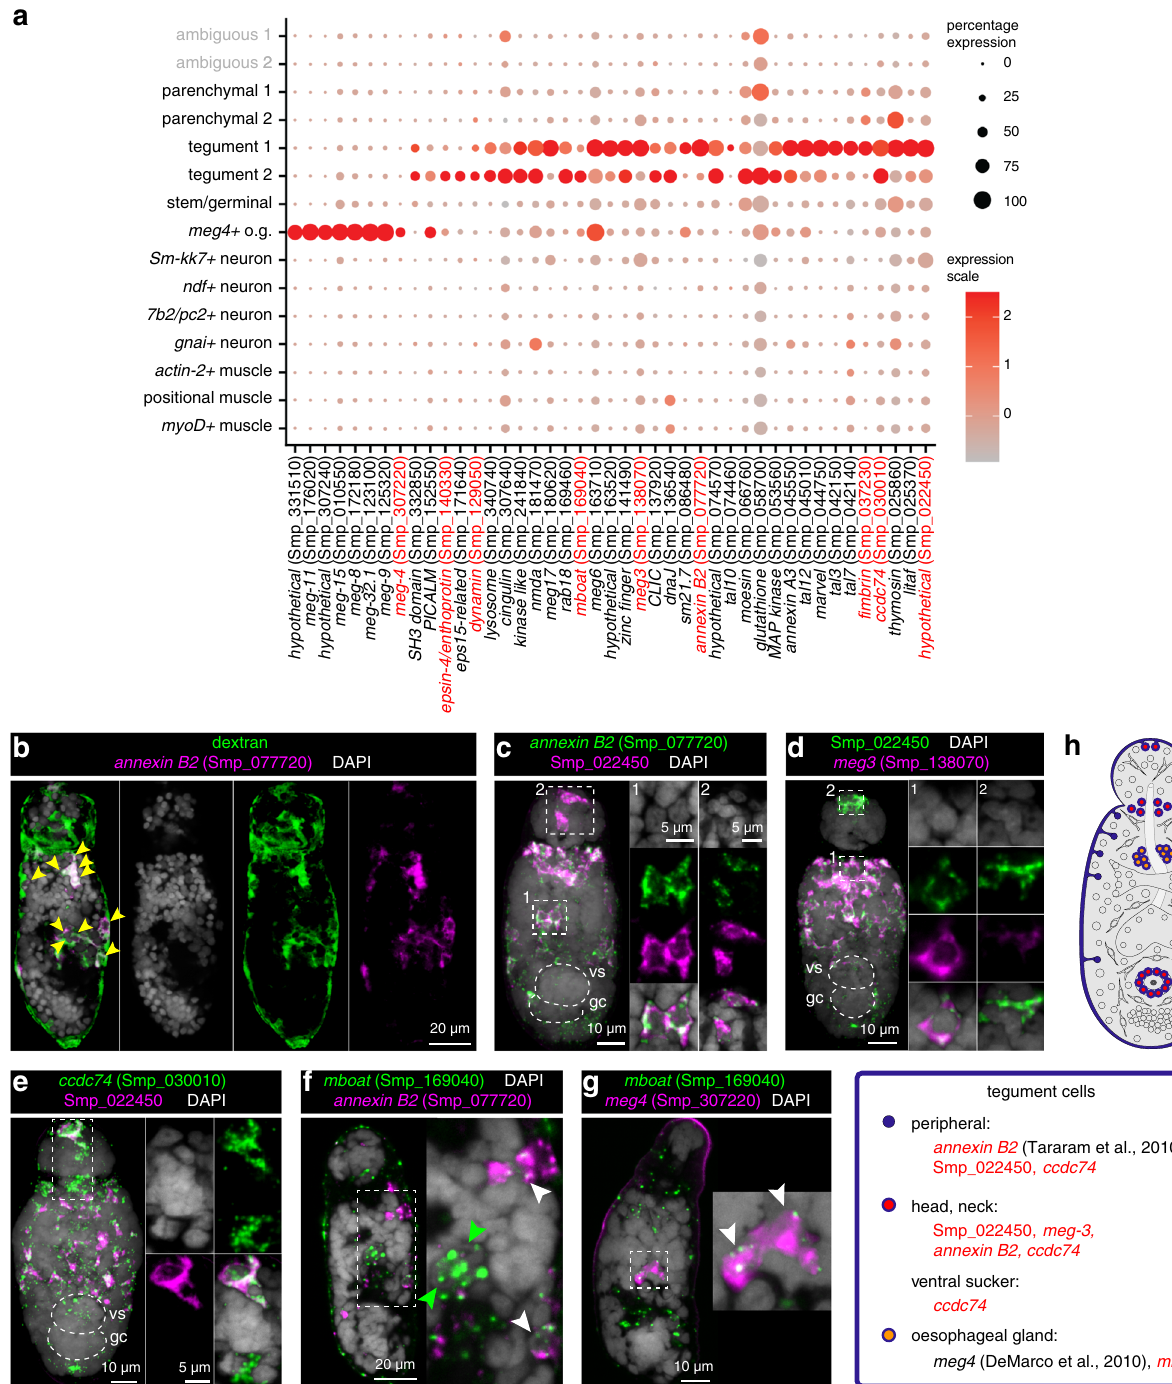
Fig. 3 Two distinct populations of tegumental cells in schistosomula. a Expression pro fi les of cell marker genes that are speci fi c to or enriched in the tegument clusters. Genes validated by ISH are marked in red. b annexin B2 + cells have taken up the fl uorescent dextran. Yellow arrowheads indicate double-positive cells. Single confocal sections are shown. c Double FISH of Tegument 1 markers annexin B2 (Smp_077720) and Smp_022450. The majority of the cells show co-localisation (white signal). Left: MIP; right: zoomed in confocal sections. vs: ventral sucker; gc: germinal cell cluster. d Double FISH of Tegument 1 markers Smp_022450 and meg3 (Smp_138070). The majority of the cells show co-localisation (white signal). e Double FISH of Tegument 1 marker (Smp_022450) with ccdc74 (Smp_030010), MIP. The majority of cells show co-localisation (white signal), while a subset of cells in the neck region of the worm show single positive cells for Tegument 2 markers. f , g Double FISH of Tegument 2 marker mboat (Smp_169040) and f Tegument 1 marker annexin B2 (Smp_077720) and g oesophageal gland marker meg4 (Smp_307220), single confocal sections. Green arrowhead: mboat + cells; white arrowhead: double-positive cells. h Schematic that summarises the tegument cell populations in 2-day old schistosomula. Marker genes identi fi ed in the current study are indicated in red. All previously reported genes are shown in black. The numbers of ISH experiments performed for each gene are listed in ‘ Methods ’ and Supplementary Data